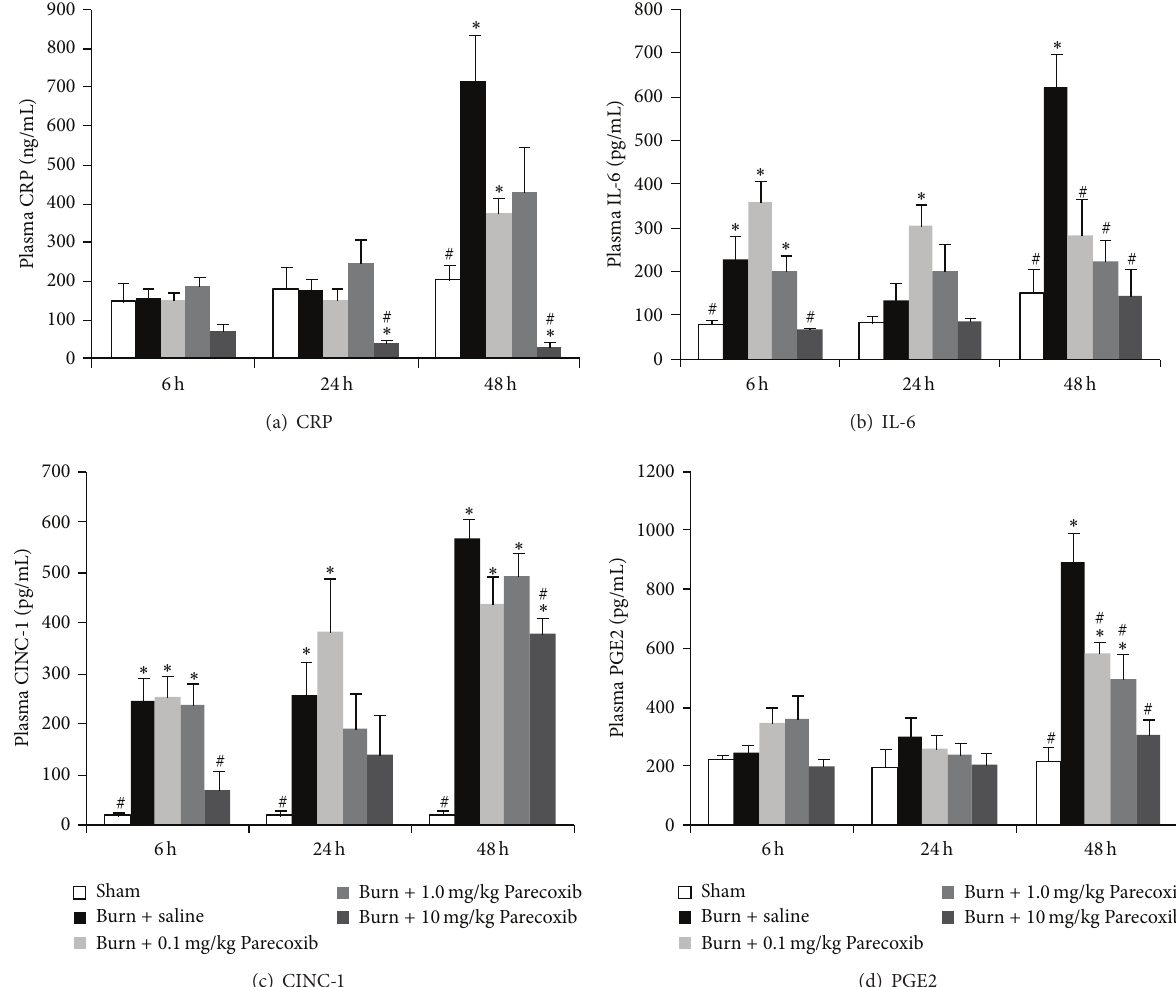
Figure6:Changesinbloodproinflammatorycytokinesover48 hafterburninjury.(a)CRP;(b)IL-6;(c)CINC-1;and(d)PGE2. ∗ Significantly different from Sham group. # Significantly different from burn + saline group ( 𝑃 < 0.05 , one-way ANOVA, Bonferroni post-hoc